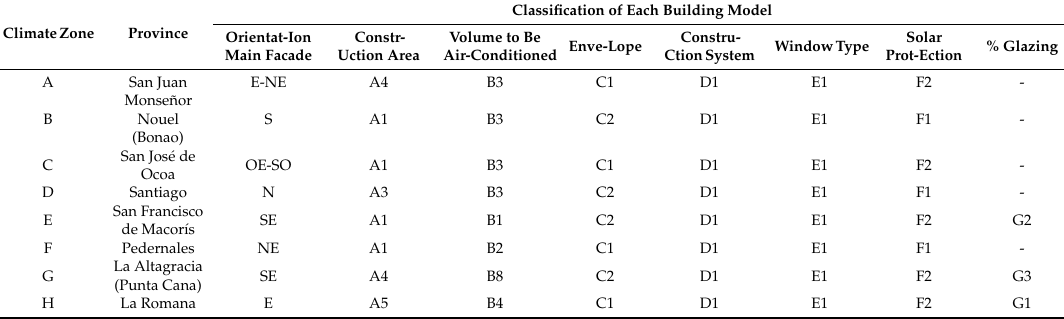
Table 6. Classification of the envelope of the building